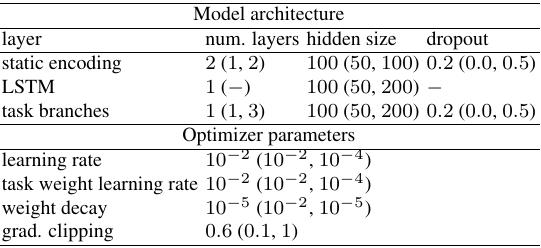
Table 1. Model architecture and optimizer hyperparameters with range limits searched in brackets (lower, upper). The static encoding layer extracts features of the static input which are fed into the LSTM together with the meteorological forcing time series. The single-layer LSTM is followed by multiple task branches. The learning rate defines the step size of the optimizer (with an independent learning rate for the task weights), weight decay adds L2 regularization (preventing large parameter values) and gradient clipping counteracts exploding gradients.